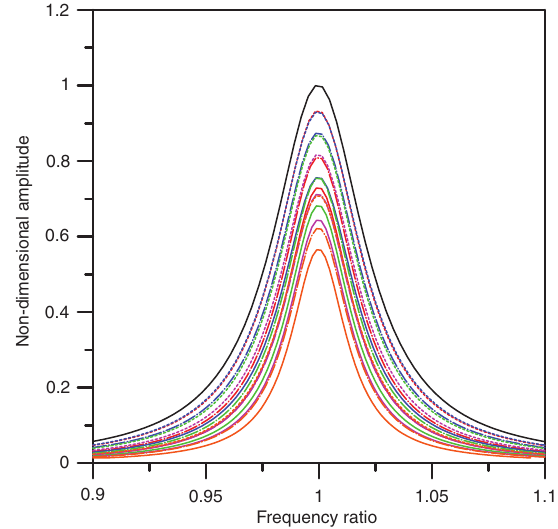
Figure 7: Forced vibration behavior of clamped square plate.